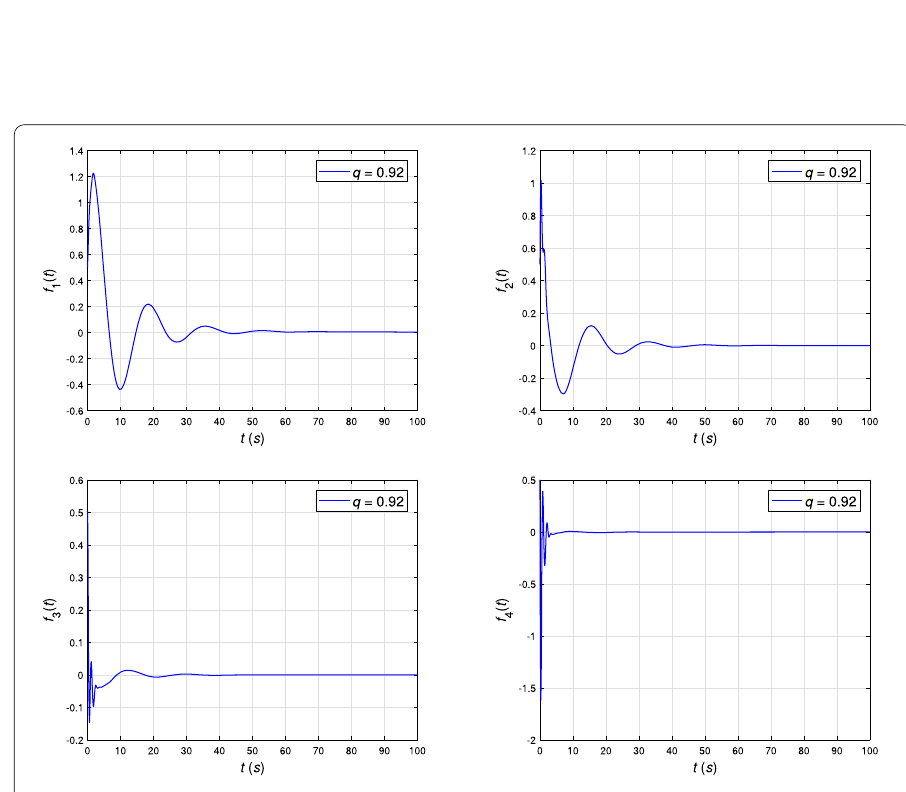
Figure 8 The time-domain responses of the controlled system (14) for q =